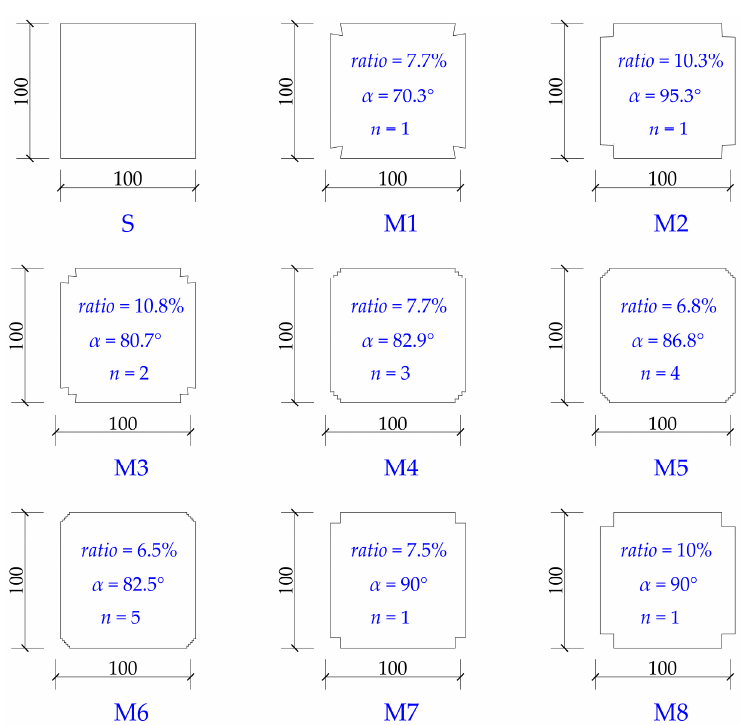
Figure 8. Schematic diagram of the geometric parameters of the benchmark section and the sections M1~M8 (Unit: mm).